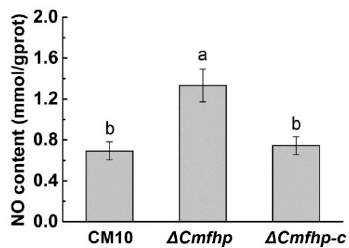
Figure 4. Analysis of the nitric oxide (NO) content in C. militaris . Different letters (a,b) indicate significant differences in the NO content.